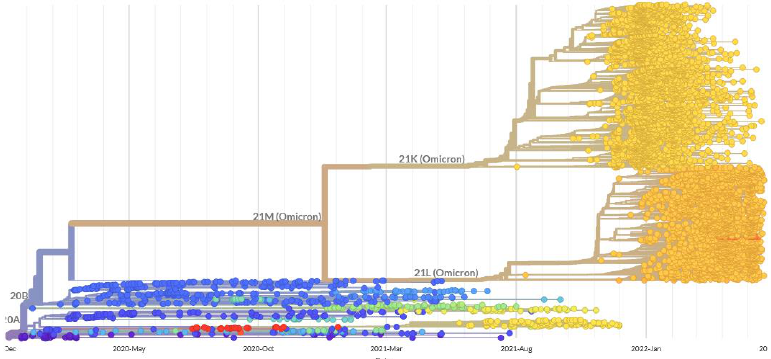
Figure 8. Phylogenetic analysis of the SARS-CoV-2 clusters, including 21K (Omicron) and 21L (Omicron). Image generated at covariants.org, on 26 May 2022. Antibodies 2022 , 11 , x FOR PEER REVIEW This work focused on human molecular mimicry-based autoimmunity risk changes in different HLA serotypes, by considering only the sequences at mutation sites of the nonmutant SARS-CoV-2 and mutant Omicron (21K and 21L) sequences into account. Such changes can influence viral evolution, yet the involvement of the HLA interactions with the spike protein [75] could be the major driving factor, along with its effects on transmis- sibility [76], and with the contribution of vaccines to this phenomenon. Accordingly, amendments of our work can involve conducting a study with a broader perspective, by including considerations on different aspects of HLA interactions, in addition to evaluat- ing the missed and eliminated data due to selected search parameters/criteria, including a possible future work on the shared 5mers. Studying mutations of the other variants, plus their recombination [77], and predicting affinities to the other alleles, including especially the class II alleles, are of importance.